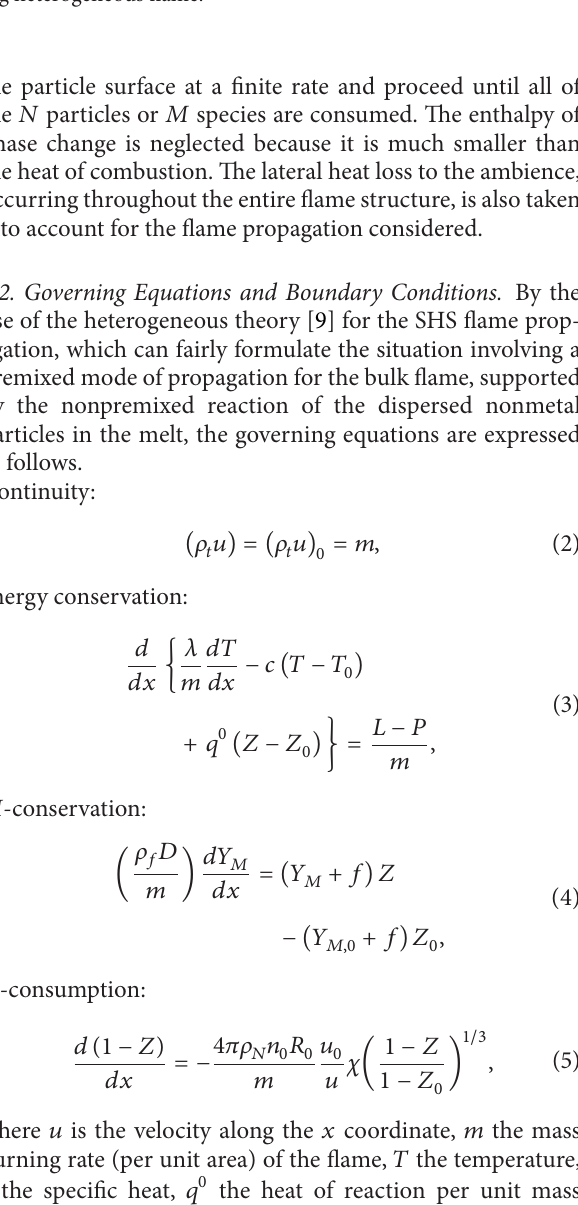
Figure 1: Schematic diagram of the flame structure in the propagat- ing heterogeneous